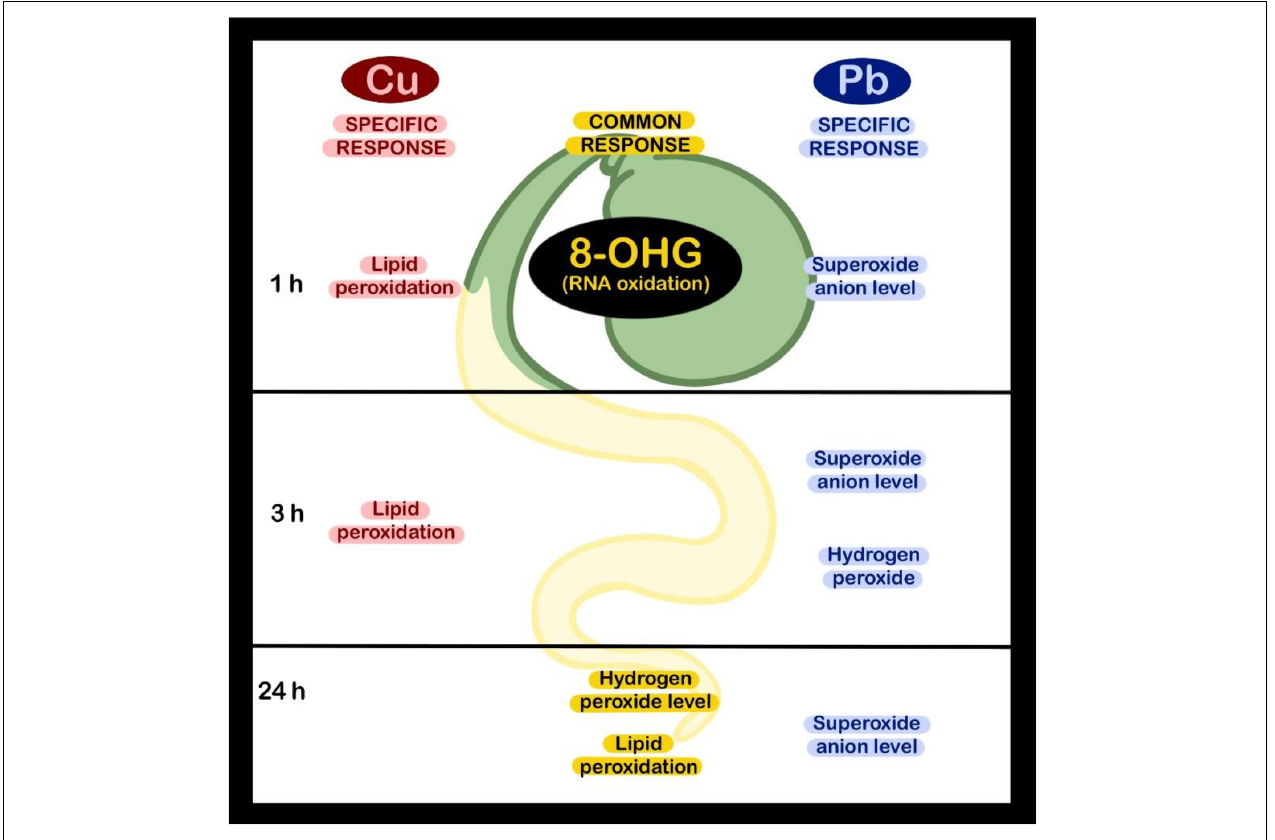
FIGURE 6 | Presentation of the elements of oxidative response induced in soybean seedlings in reaction to short-term Cu or Pb